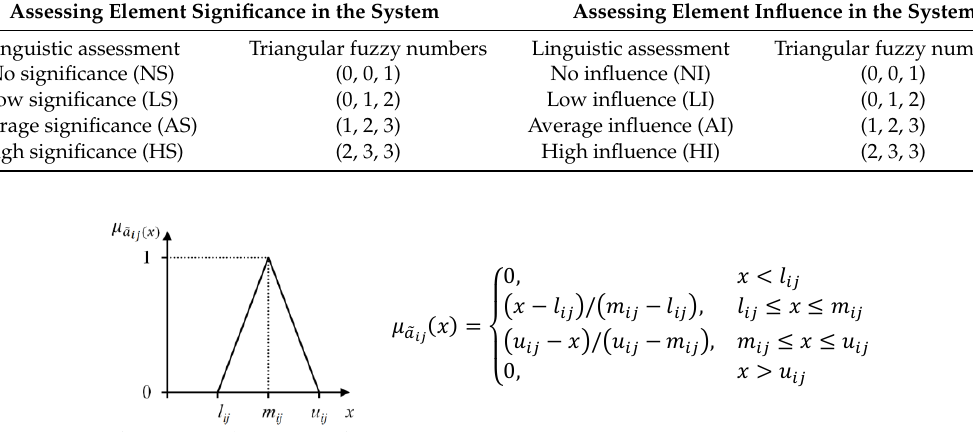
Table 1. Linguistic assessment of element significance and influence and their representation as triangular fuzzy sets, based on [29].